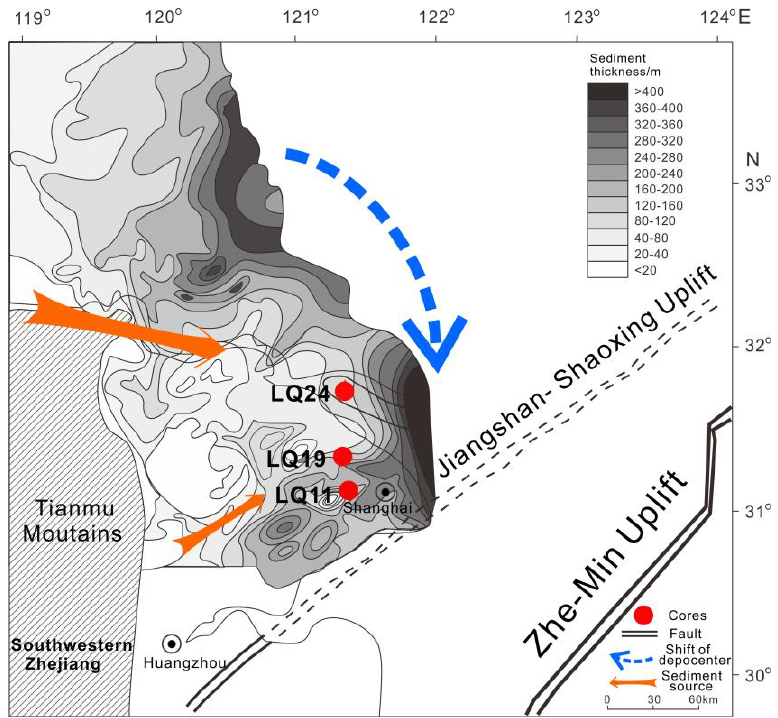
Figure 9. Sediment sources of the Yangtze Delta in the Quaternary. The contours of the sediment were modified after [45].